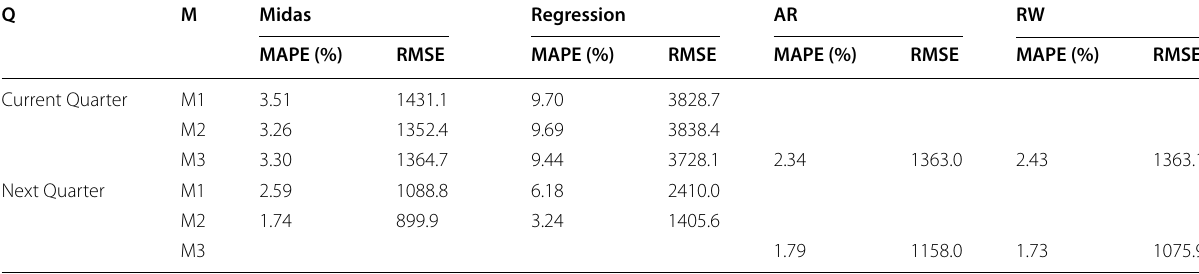
Table 6 MAPE and RMSE loss functions for the consumption models